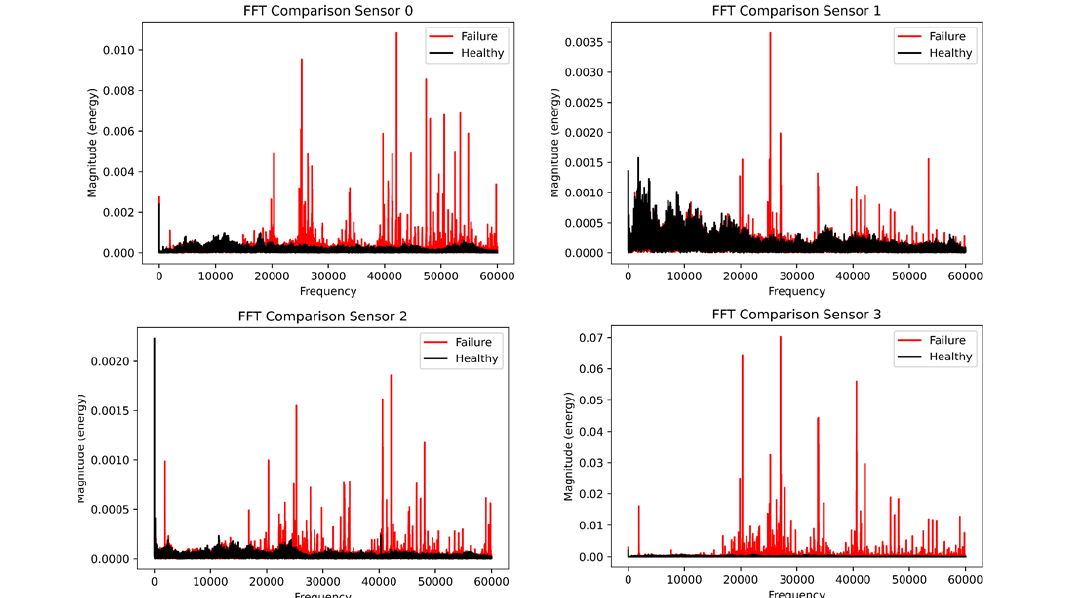
Figure 9. The healthy and faulty comparison using the fast Fourier